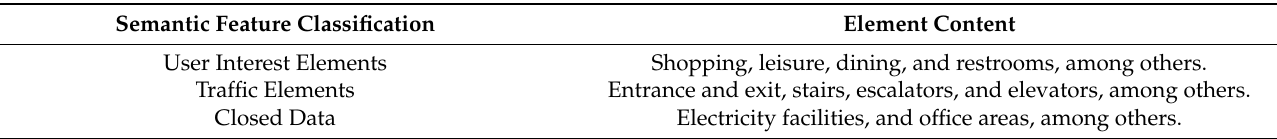
Table 2. Semantic classification of indoor area features in shopping